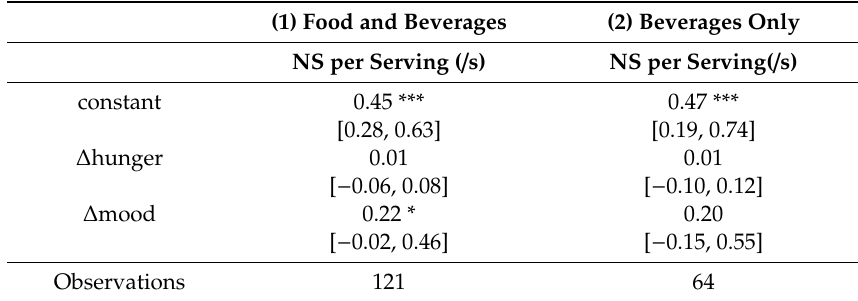
Table 4. The heterogeneous e ff ects of the dynamic food labels with real-time feedback (DFLF) on nutritional quality by hunger and